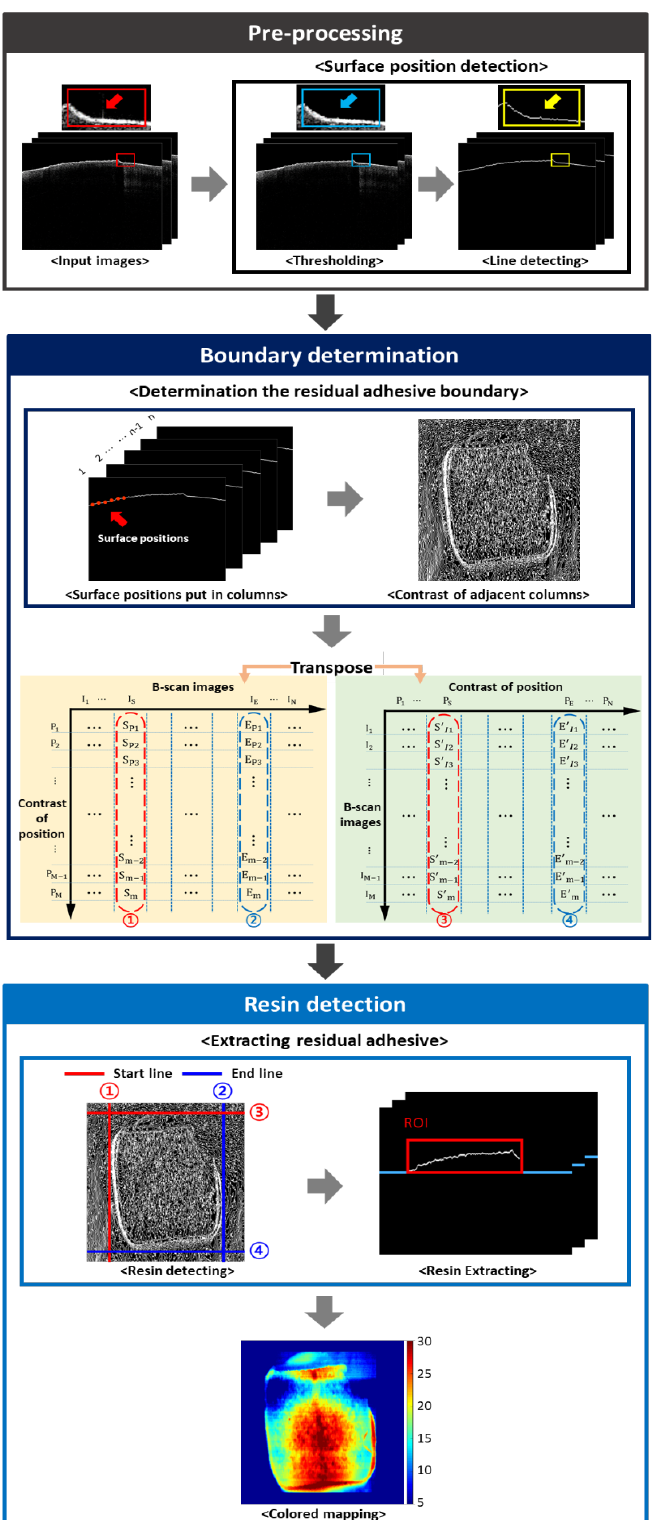
Figure 3. The flow chart of the residual adhesive detection procedure coded using MATLAB. The flow chart consists of three steps, such as pre-processing, boundary determination, and resin detection. In pre-processing, noise is removed and surface positions are detected. In boundary determination, the lines of boundary of residual adhesive are detected, while in resin detection, the residual adhesive from dental surface is extracted and quantitatively analyzes the area of residual